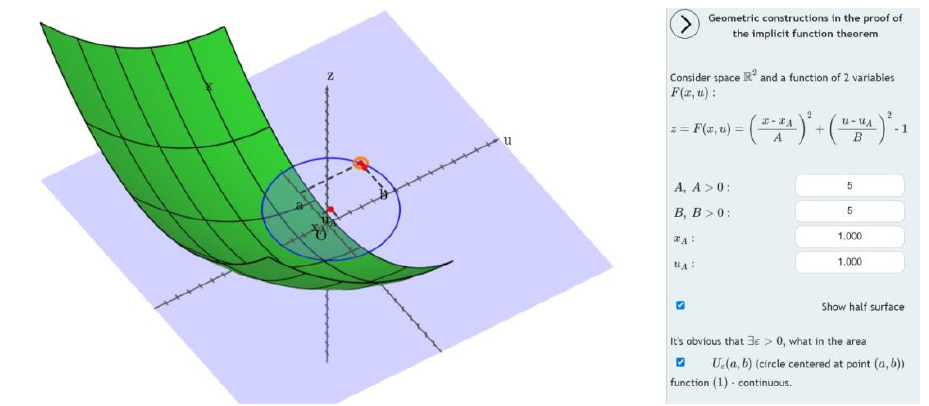
Fig. 2. Visual-geometric proof of the theorem.